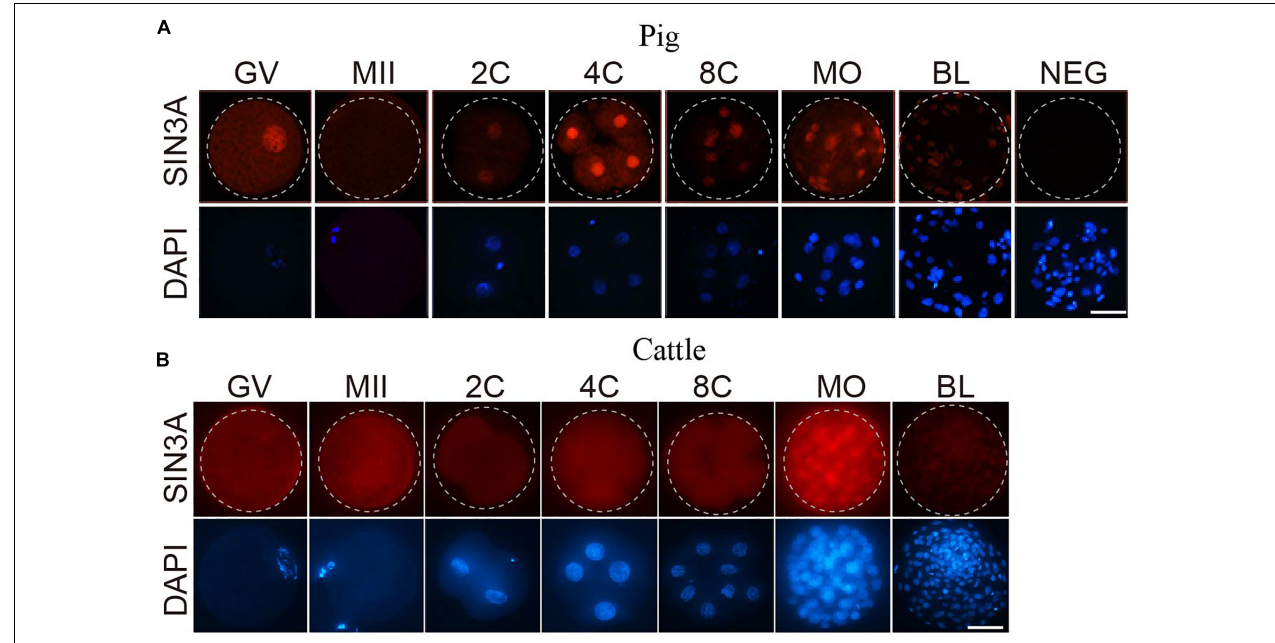
FIGURE 2 | Immunofluorescence detection of SIN3A protein during oocyte maturation and embryonic development in pig and cattle. (A) Pig. (B) Cattle. SIN3A protein (red) was probed with mouse anti-SIN3A antibodies and detected by Alexa 594-conjugated goat anti-mouse antibodies. Nuclei (blue) were labeled with DAPI stain. The experiment was independently repeated three times with at least 10 oocytes or embryos per stage. Scale bar = 50 µ M.